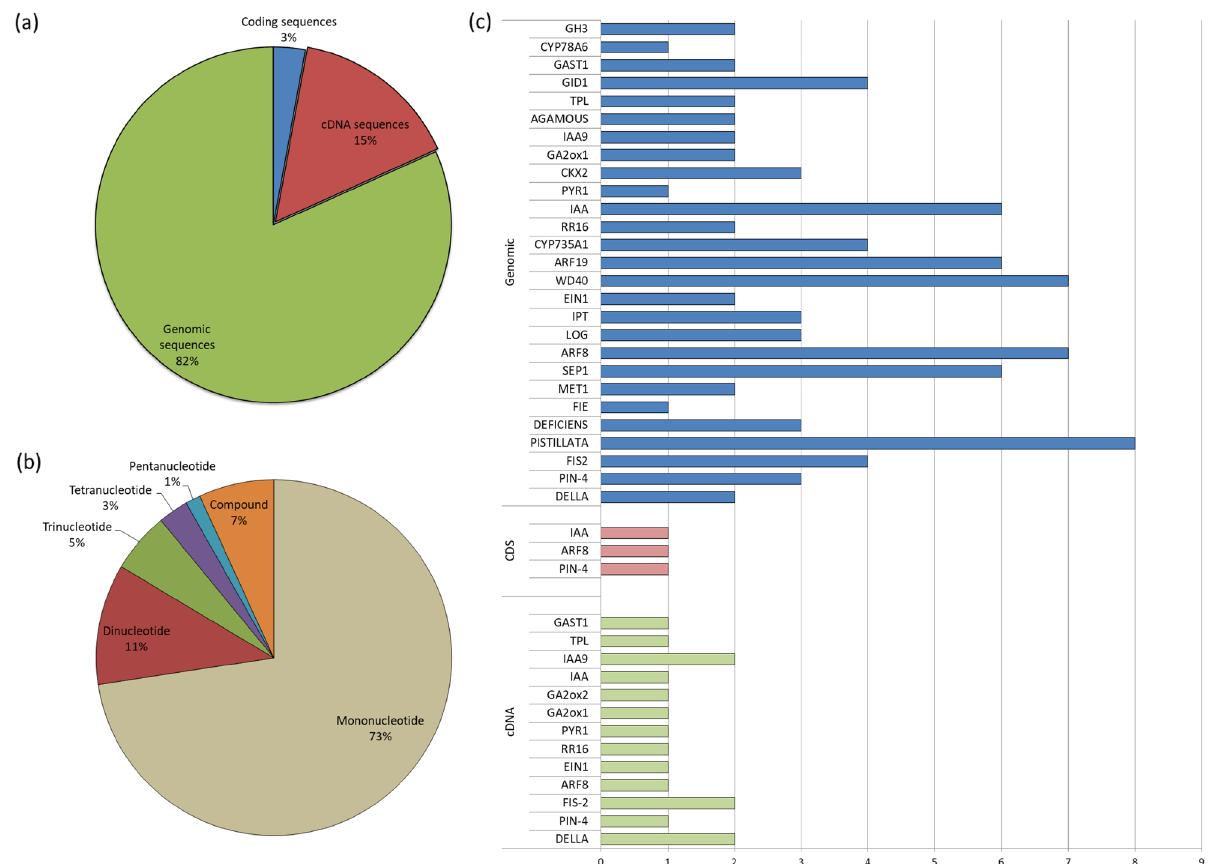
Figure 8. (a) Distribution of SSR markers among genomic, cDNA and coding sequences of PRGs (b) Abundance of mono-, di-, tri-, tetra-, penta-nucleotide repeats and compound SSRs in genomic sequences of PRGs. (c ) Number of SSRs discovered from genomic, cDNA and coding sequences of various